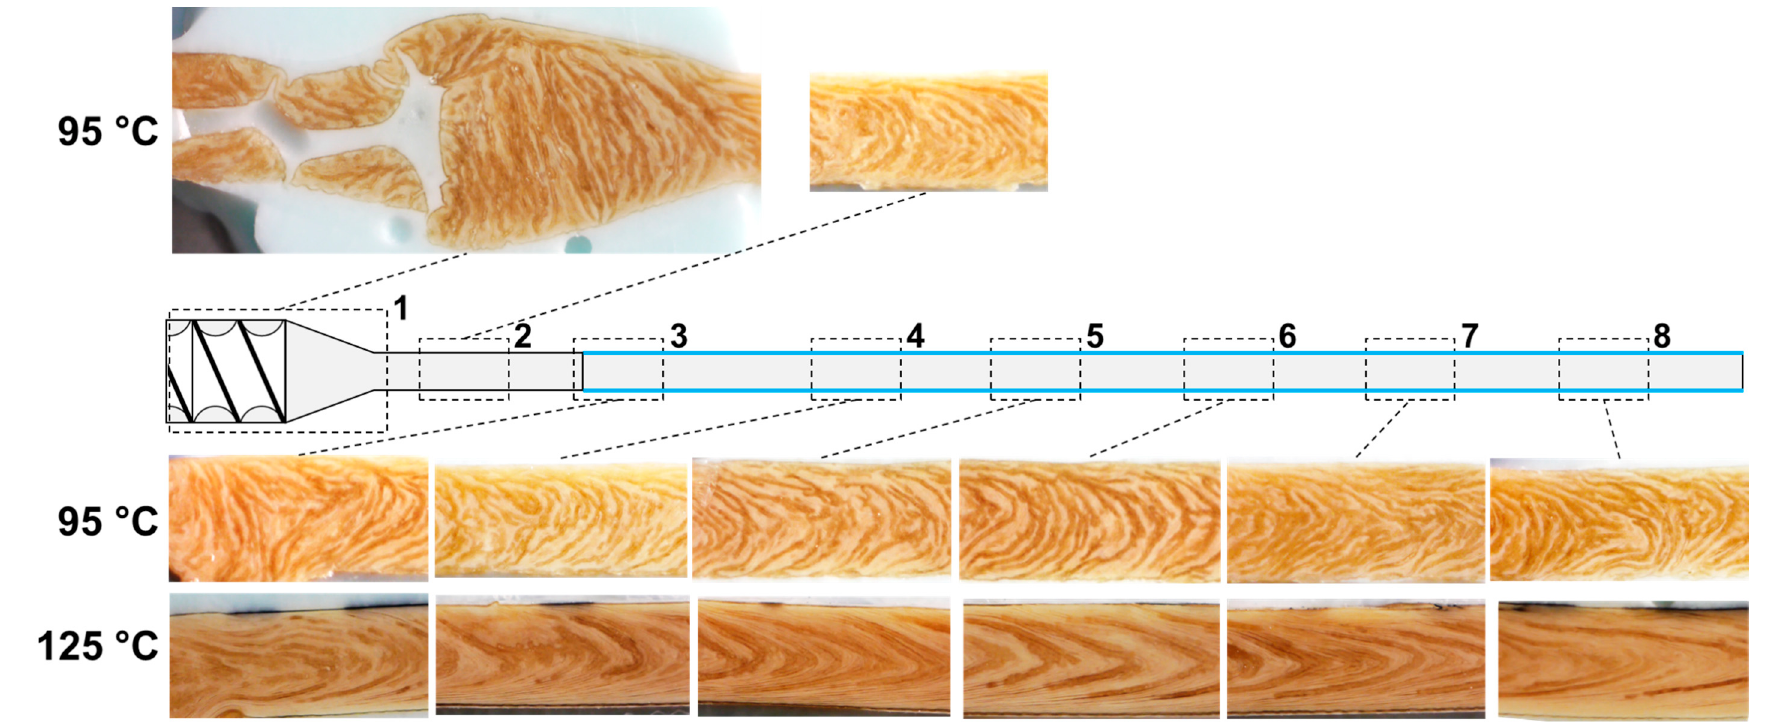
Figure 7. Morphology of samples obtained through cryo-imaging in dead-stop trials at T Material = 95 °C and 125 °C from different locations in the die section. Flow direction is from left to right.